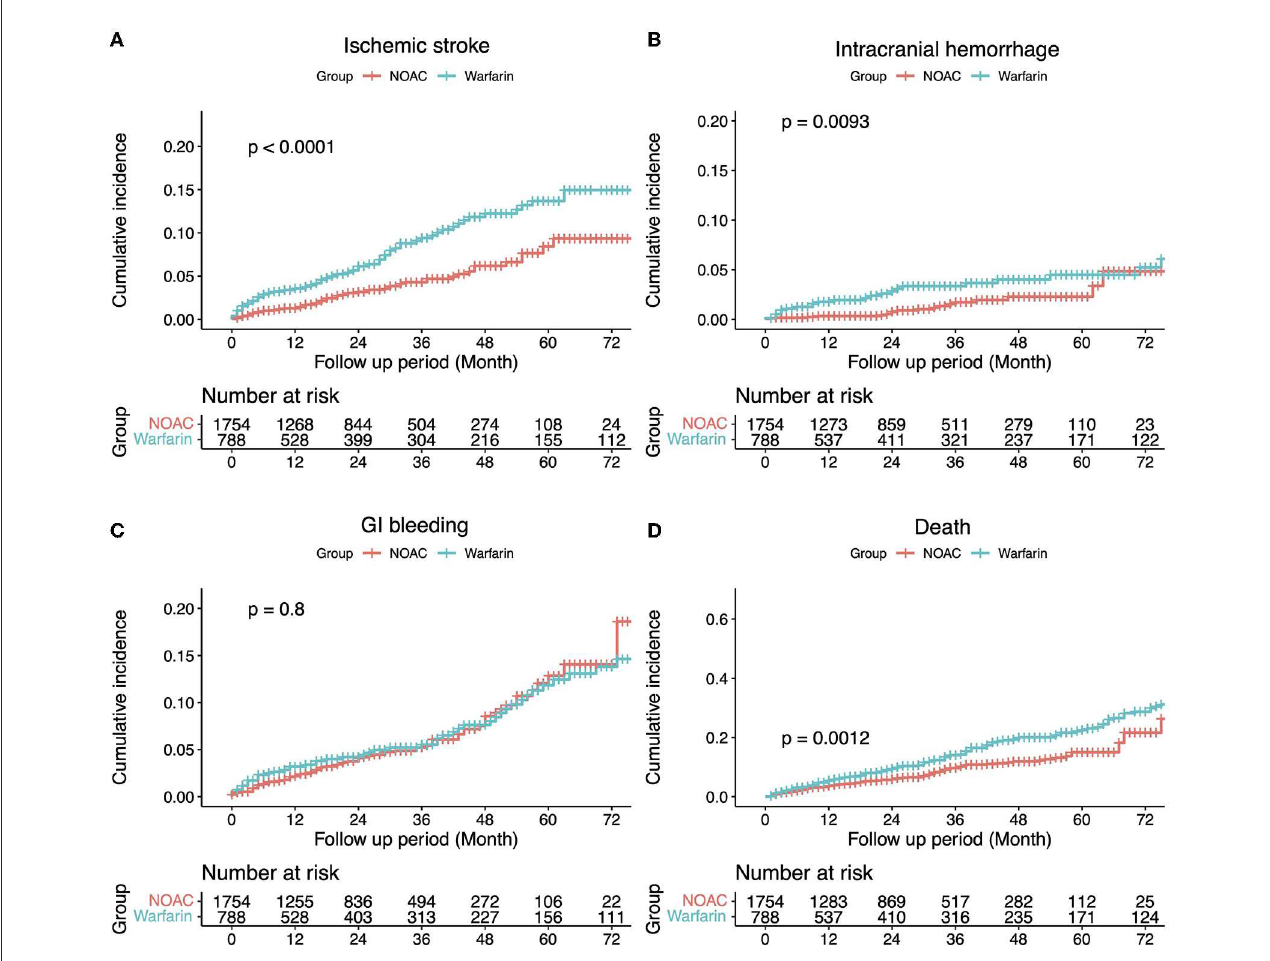
FIGURE3 The incidence of each outcome was estimated using the Kaplan–Meier estimator. Comparisons between groups were made using a log-rank test (A) Ischemic stroke, (B) Intracranial hemorrhage, (C) Gastrointestinal bleeding, and (D) Death.